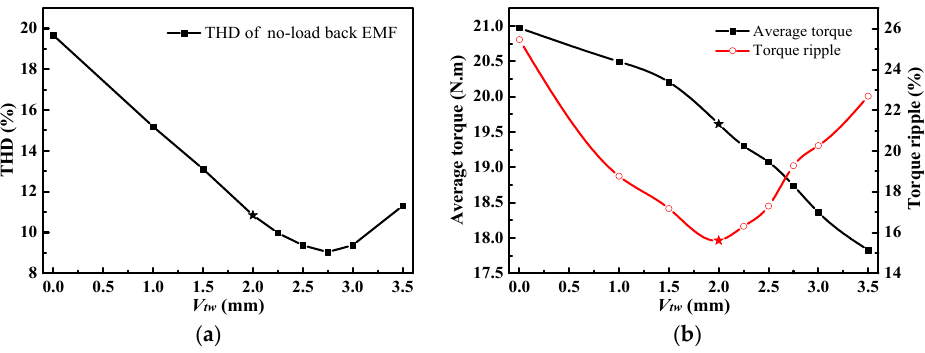
Figure 12. THD, average torque and torque ripple: ( a ) THD of no-load back-EMF with increasing V tw ; ( b ) Average torque and torque ripple with increasing V tw .